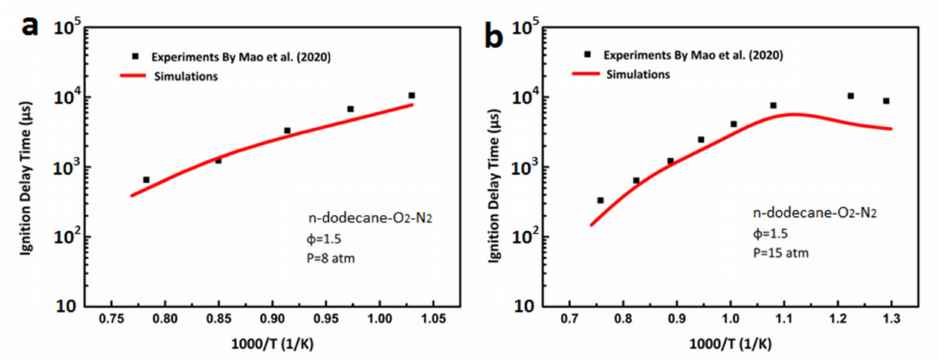
Figure 3. ( a ) Comparison of simulated and experimental ignition delay time of n-dodecane at Φ = 1.5, 8 atm; ( b ) Comparison of simulated and experimental ignition delay time of n-dodecane at Φ = 1.5, 15 atm.